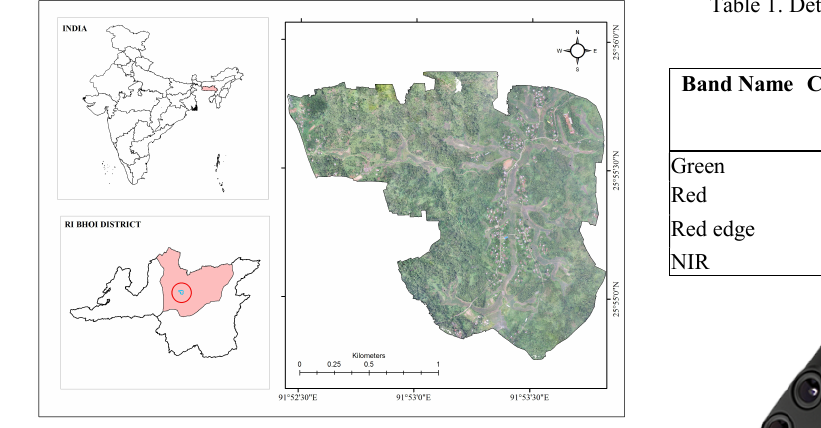
Figure 1. Location map of study village